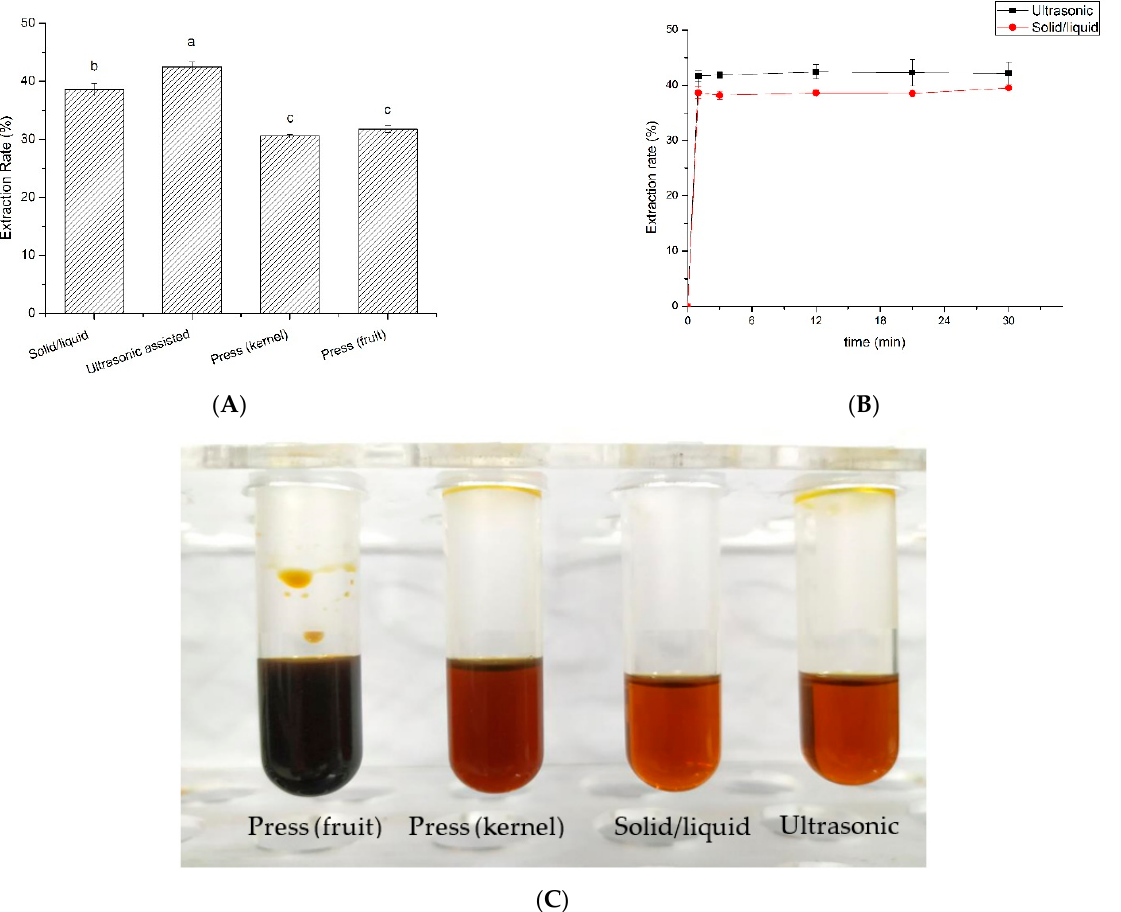
Figure 4. ( A ) The effect of extraction methods on the extraction rate of Litsea cubeba oils, columns marked by the same letter are not significant at p < 0.05. ( B ) Kinetics comparison of conventional solid–liquid extraction and ultrasound-assisted extraction as the function of extraction time, ( C ) the appearance of Litsea cubeba oils extracted from different methods.